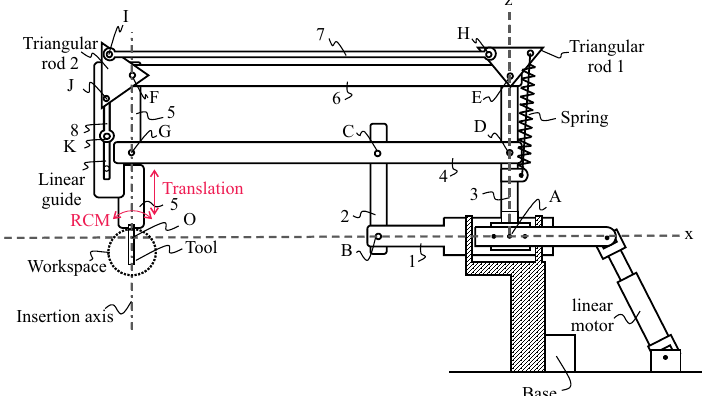
Figure 2. Candidate architecture of the robot with its security, where the numbers represent the names of the rods, and the letters the names of the rotation